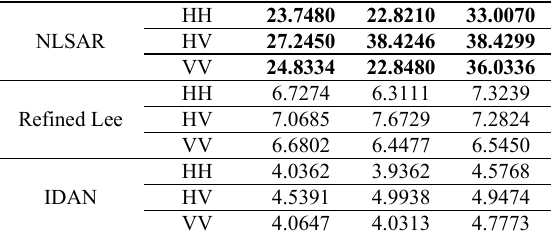
Table 2. ENL of homogeneous areas selected from filtered TerraSAR-X data Higher ENL implies better speckle reduction. The best two filters: NLSAR and the newly designed kernel combined with the information approach, are marked in bold in Table 2. Detail